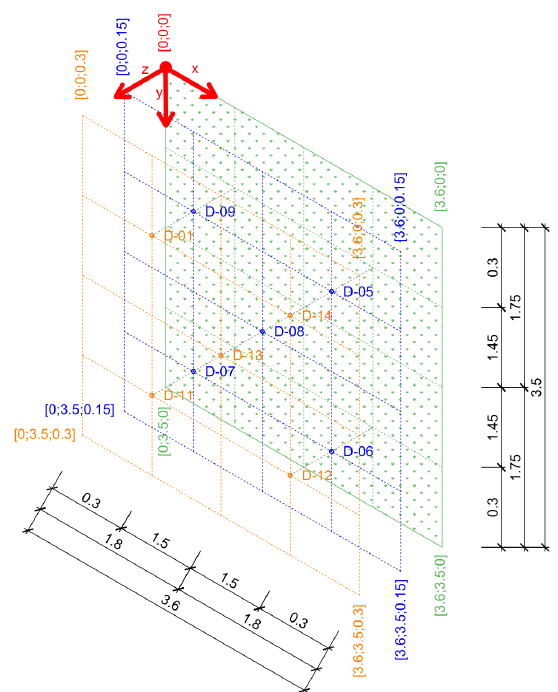
Figure 2. Graphical representation of the positioning of dataloggers on the model LW in the LIKO-S company (into two layers, 5 dataloggers in each layer). Every datalogger on model LW has its own coordinates. Each of the dataloggers on the model wall has its own coordinates, distributed in a grid.